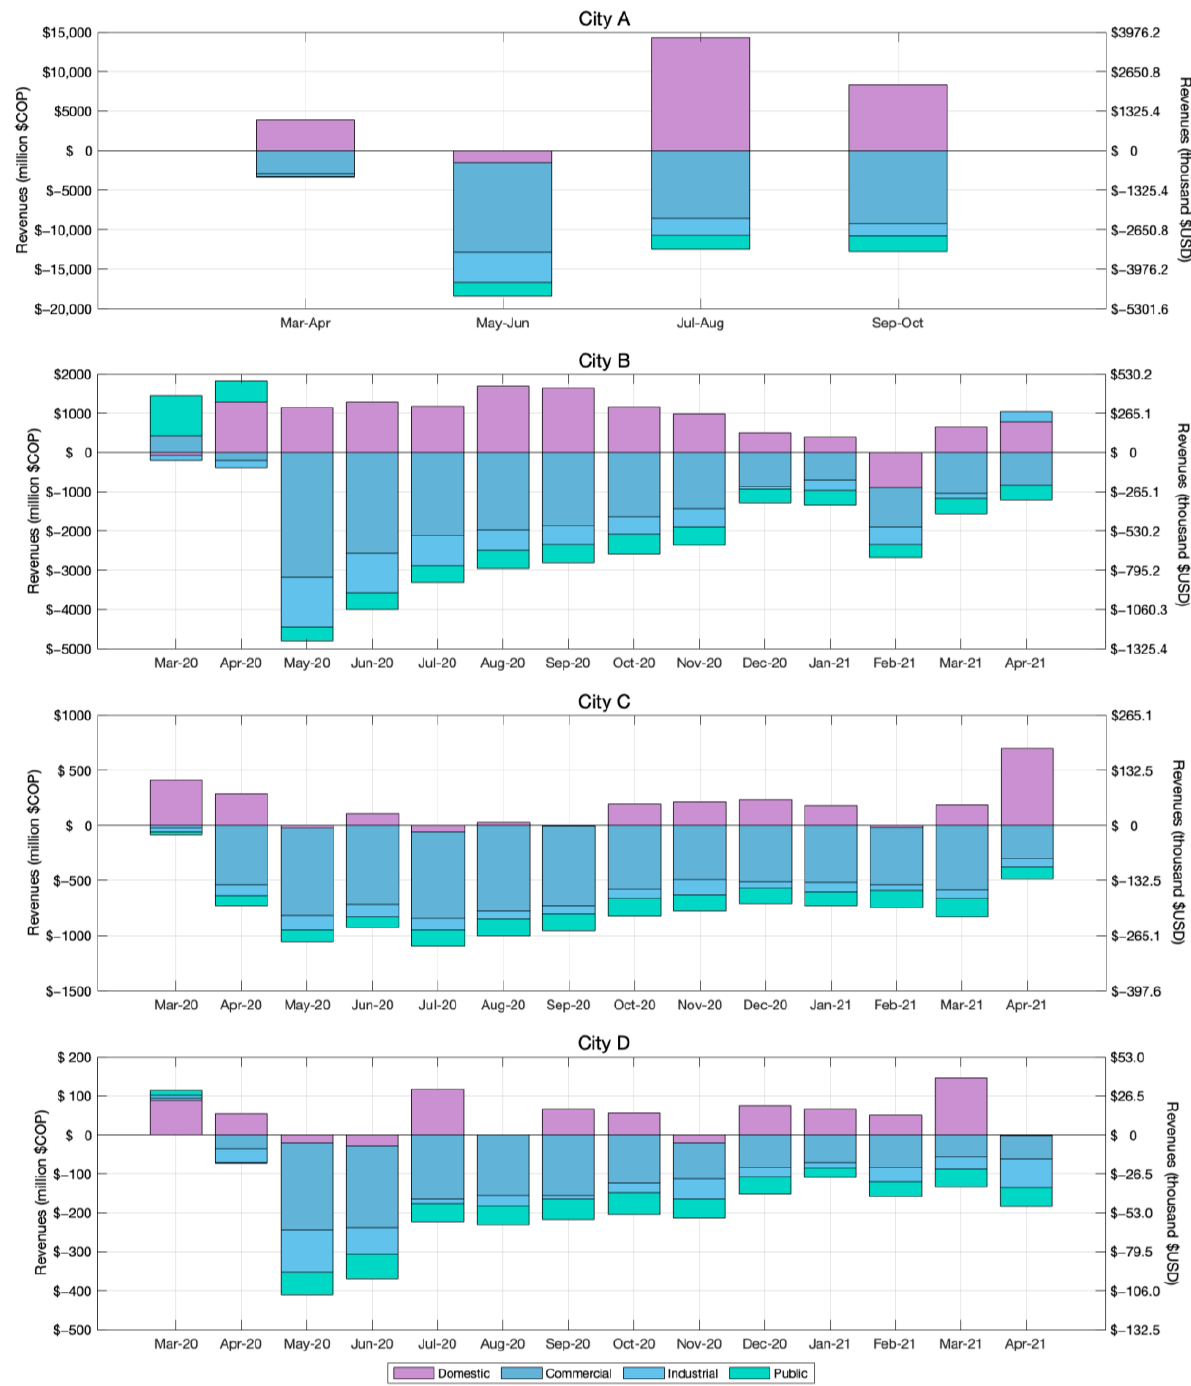
Figure 7. Difference between actual and expected revenues for domestic, commercial, industrial, and public water consumption in each case study. The left axis shows the revenues in millions of Colombian pesos and the right axis in thousands of US dollars. Commas are used for indicating thousands and periods for decimals.